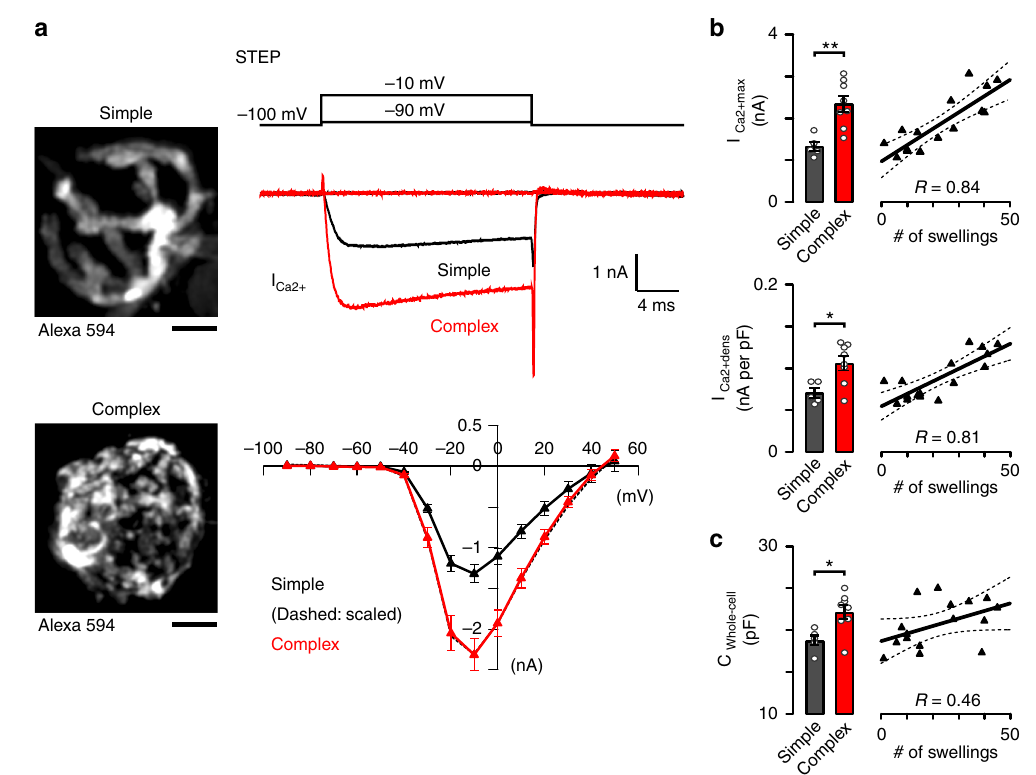
Fig. 3 Ca 2 + current density is larger in complex calyces. a Example calyces are visualized in z -axis projection images. Representative traces show presynaptic Ca 2 + currents (I Ca2 + ) recorded from simple (black) and complex (red) calyces kept at − 100 mV. I Ca2 + -s were tested by voltage steps between − 90 and + 50 mV with 10 mV increments (see schematic drawing). Average voltage-dependence curves of step I Ca2 + -s (mean ± SEM) are shown in simple and complex calyces. Amplitude-scaled version of simple calyx I – V curve (dashed black) overlaps with the complex one. b , c Bar graphs show the maximal step I Ca2 + amplitude (I Ca2 + max ), step I Ca2 + density (I Ca2 + dens ), and whole-cell capacitance (C whole-cell ) of simple and complex calyces (step I Ca2 + amplitude, simple, 1.33 ± 0.11 nA, n = 5/4, complex, 2.34 ± 0.20 nA, n = 8/7, t = 3.846, p = 0.003, df = 11, unpaired t -test [u.t.t]; step I Ca2 + density, simple, 0.071 ± 0.0057 nA per pF, n = 5/4, complex, 0.106 ± 0.0087 nA per pF, n = 8/7, t = 2.974, p = 0.013, df = 11, u.t.t.; C whole-cell , simple, 18.8 ± 0.62 pF, n = 5/4, complex, 22.2± 0.83 pF, n = 8/7, t = 2.918, p = 0.014., df = 11, u.t.t.). Scatter-plots of individual experiments (right) were fi tted with linear function (mean ± 95% con fi dence interval). R demonstrates correlation strength. Bar graphs summarize mean ± SEM (* p < 0.05, ** p < 0.01). See Supplementary Figure 4. Scale bars: 5 μ m ( a